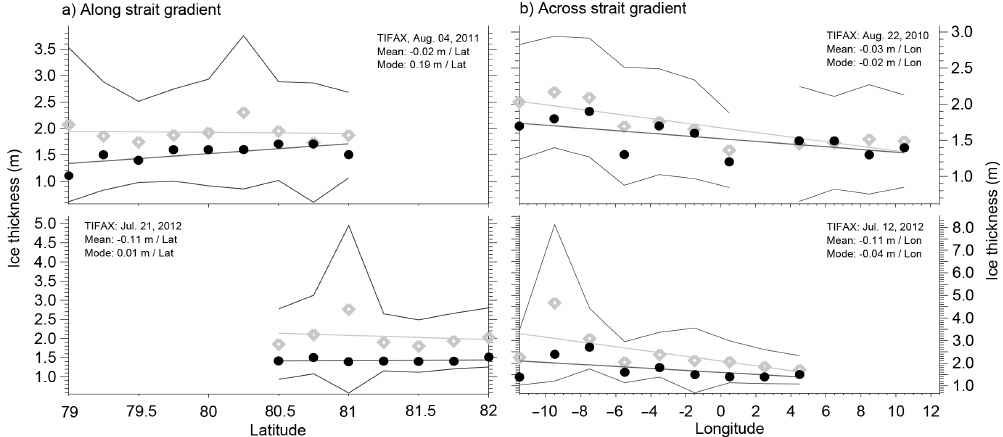
Figure 6. Across- and along- Fram Strait thickness gradients: (a) Along-strait flights made in August 2011 and 2012 between 10 ◦ W and 0 ◦ E. (b) : Across-strait flights made in 2010 (at 81 ◦ N) and 2012 (at 82 ◦ N). Gray rectangles correspond to the mean thickness with standard deviation (black solid lines), whereas black circles indicate modal thickness. The corresponding trend lines are plotted on